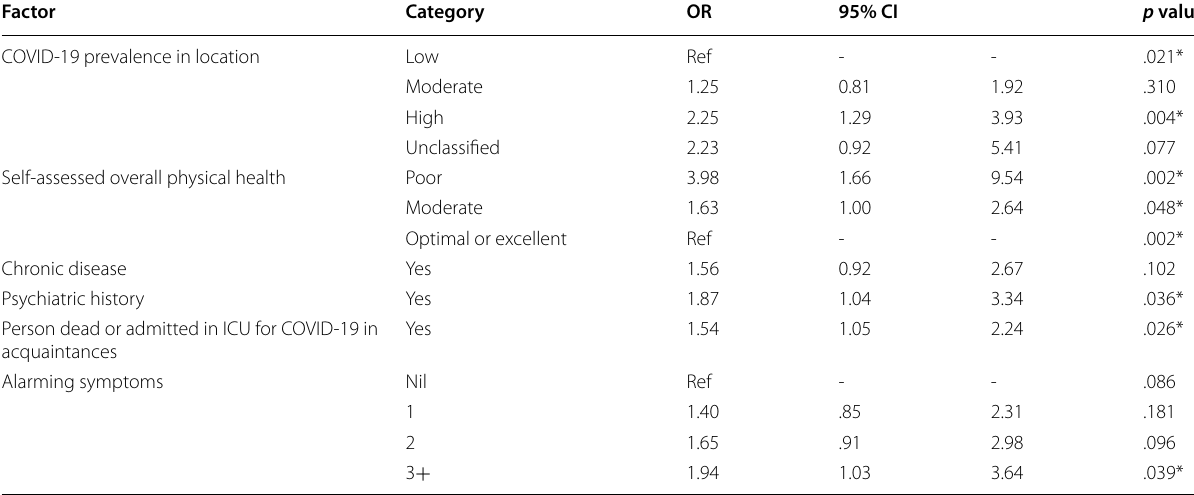
Multivariate logistic regression: dependent variable OR odds-ratio, 95% CI 95% confidence interval, Ref category used as reference in the regression equation *Statistically significant result ( p <